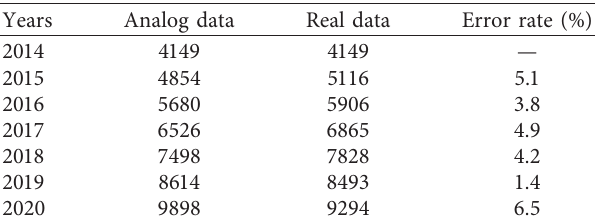
Table 5: Economic benefit fitting